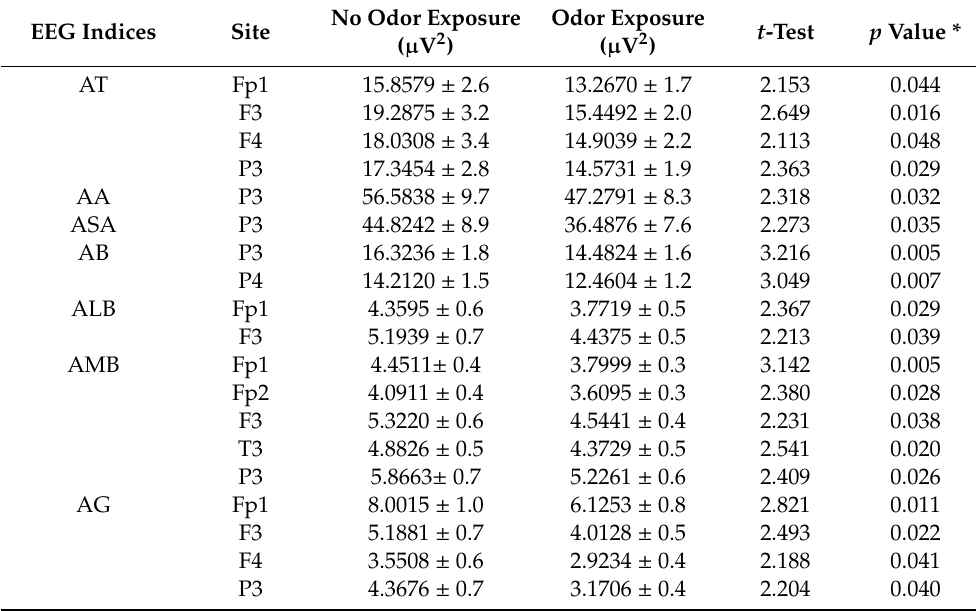
Table 3. Significant changes of EEG power spectrum values during the right nostril inhalation of C10